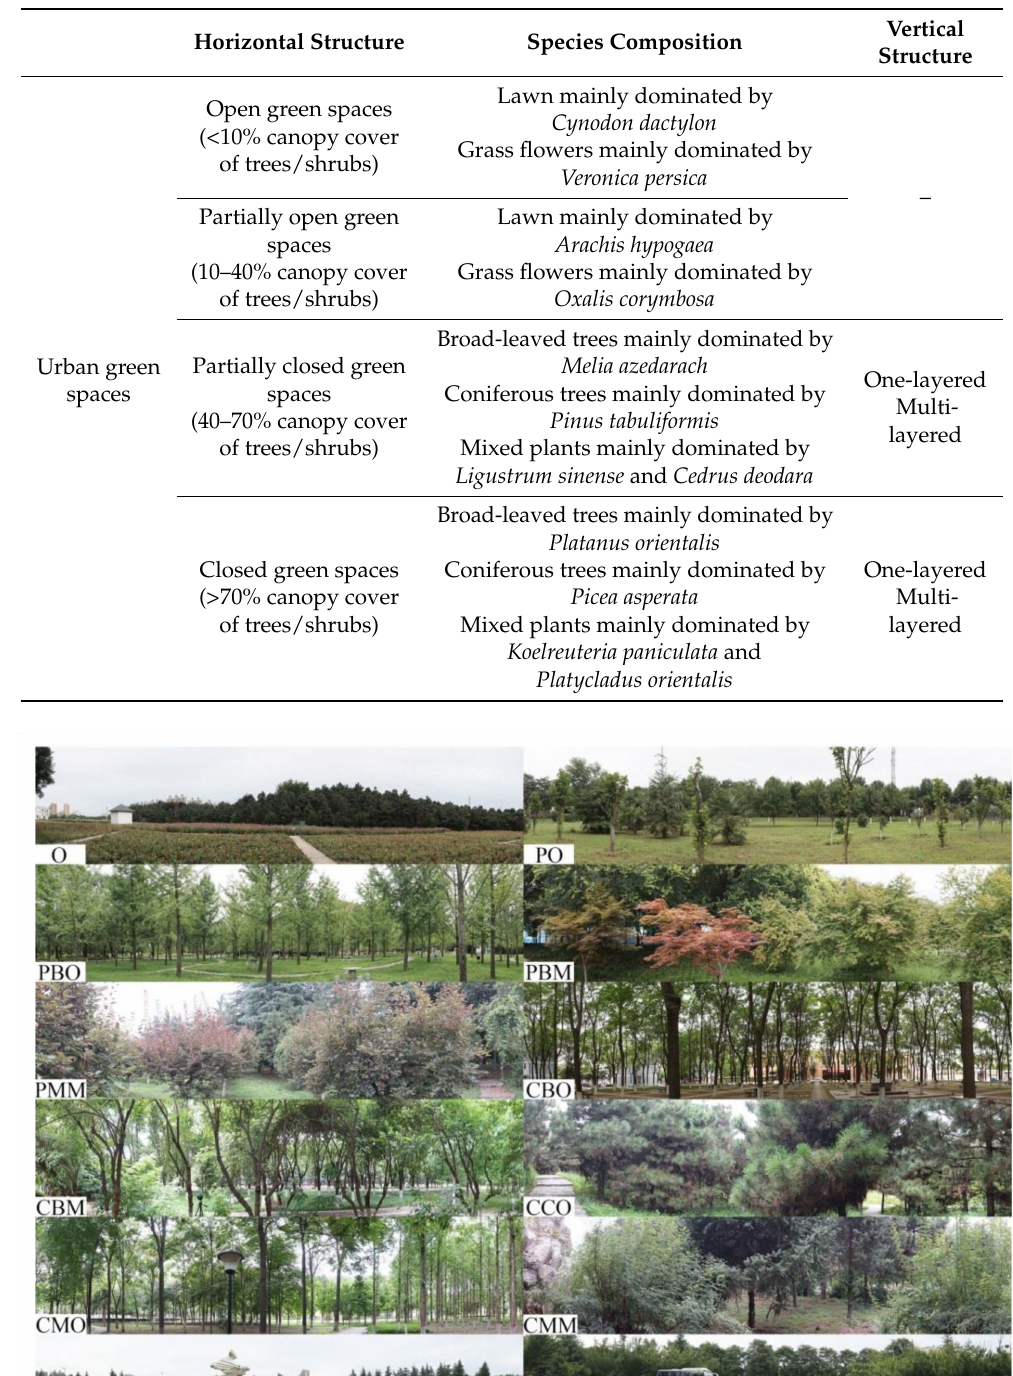
Table 1. Classification with three levels shown for urban green spaces.